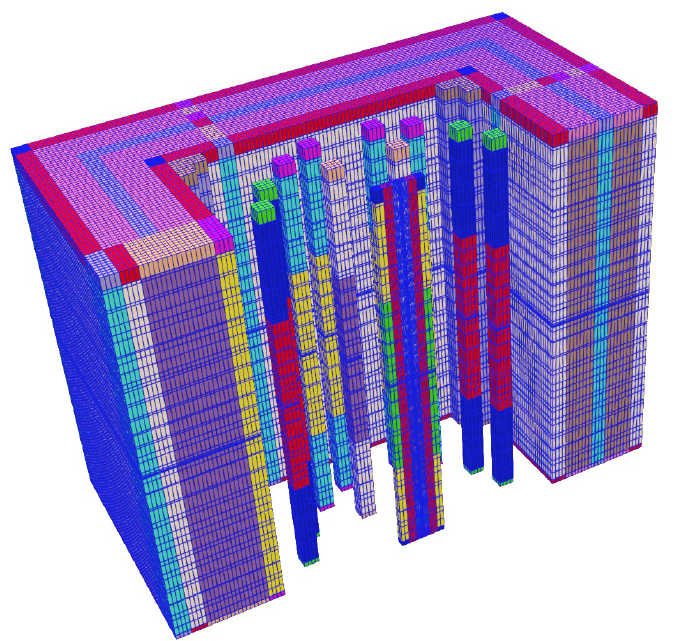
Figure 8. Three-dimensional view of the mesh, showing the experimental position, control rod fuel elements and reflector for the SIRIUS-CAL